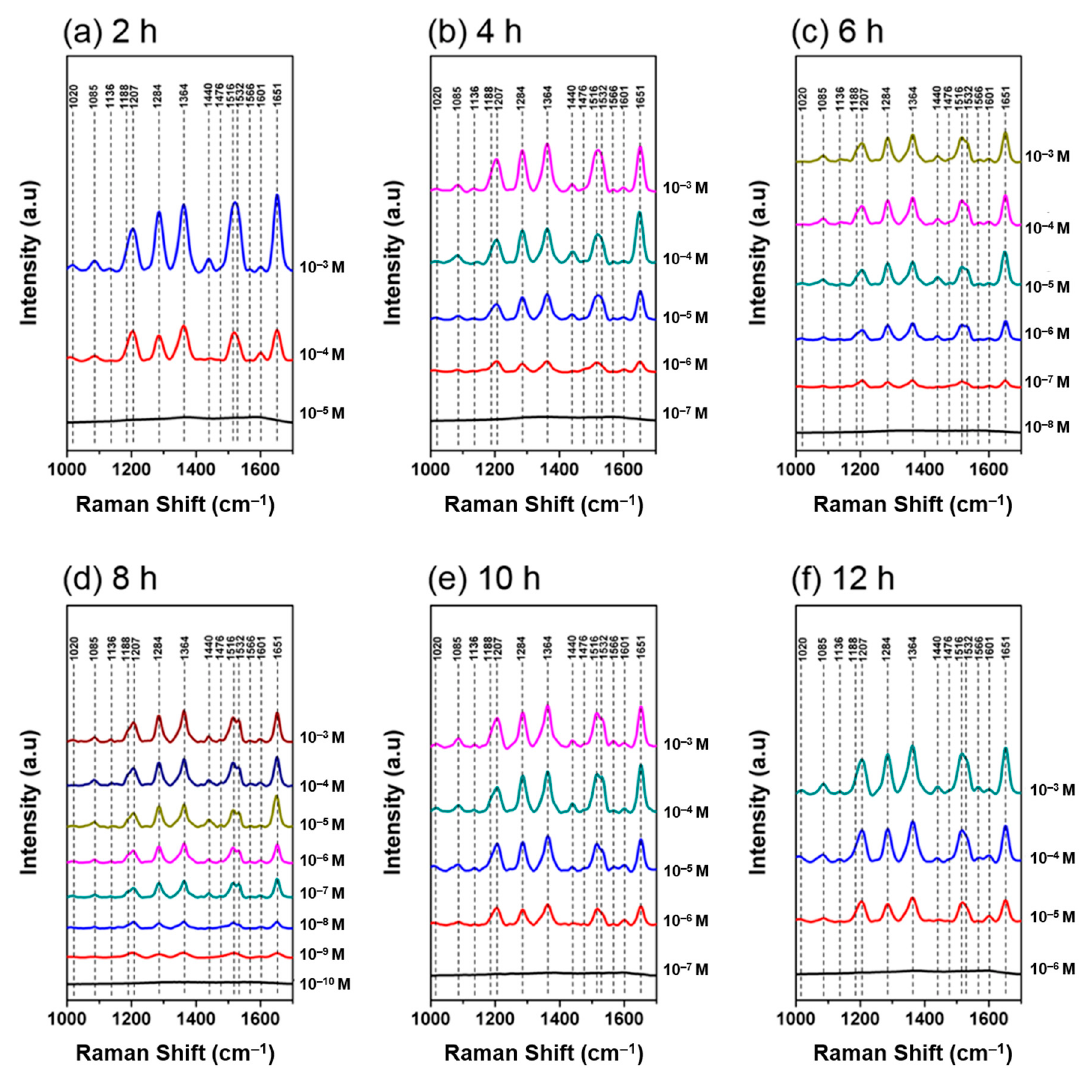
Figure 5. SERS spectra of different Rhodamine B concentrations for substrate detection at increasing AgNP deposition times—( a ) 2 h, ( b ) 4 h, ( c ) 6 h, ( d ) 8 h, ( e ) 10 h, and ( f ) 12 h.